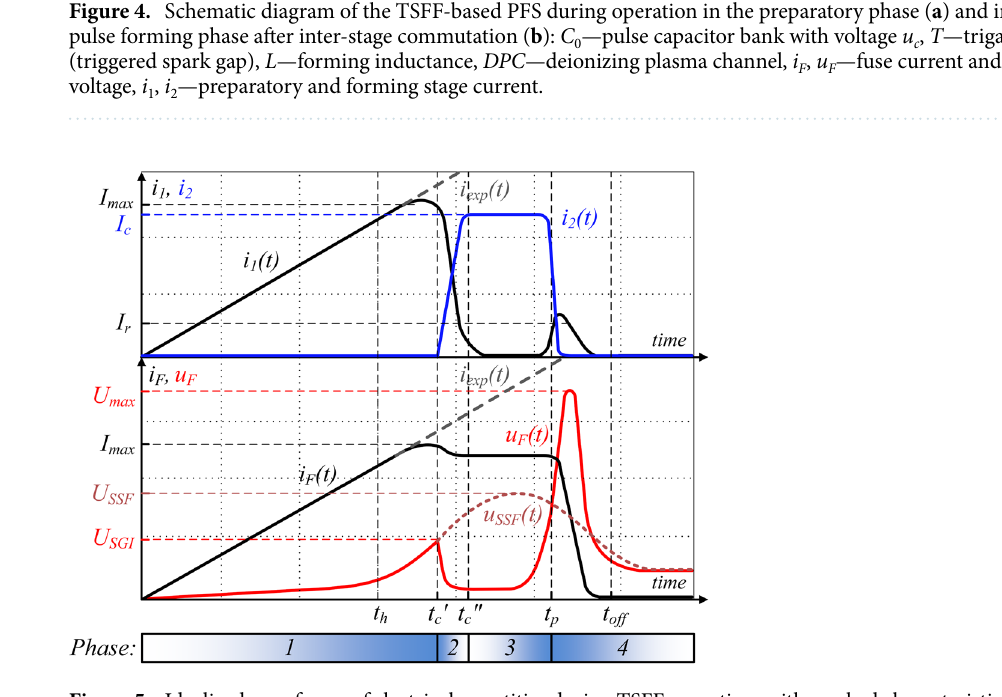
Figure 5. Idealized waveforms of electrical quantities during TSFF operation, with marked characteristic values (symbols in accordance with Fig. 4 and the descriptive text). Illustrative drawing not to